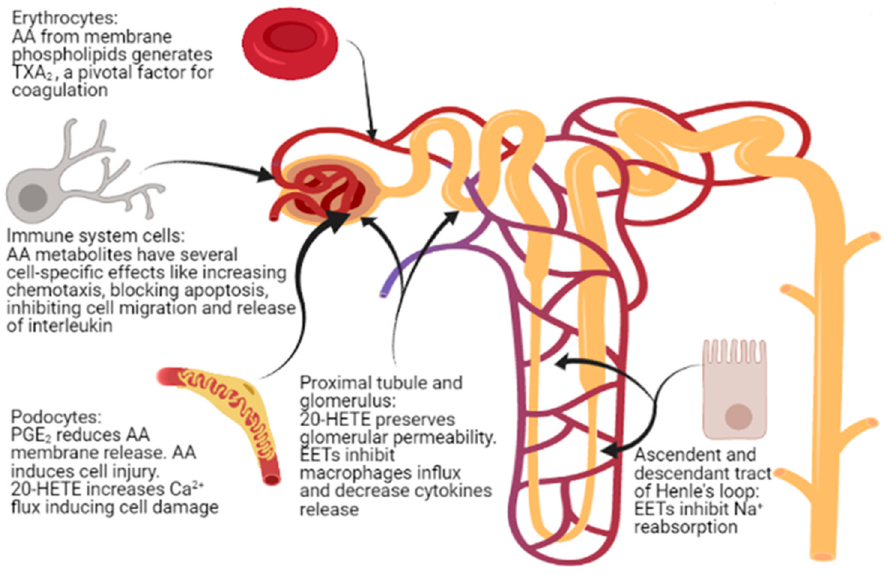
Figure 3. Sites of action of arachidonic acid (AA) and its metabolites in nephrotic syndrome.